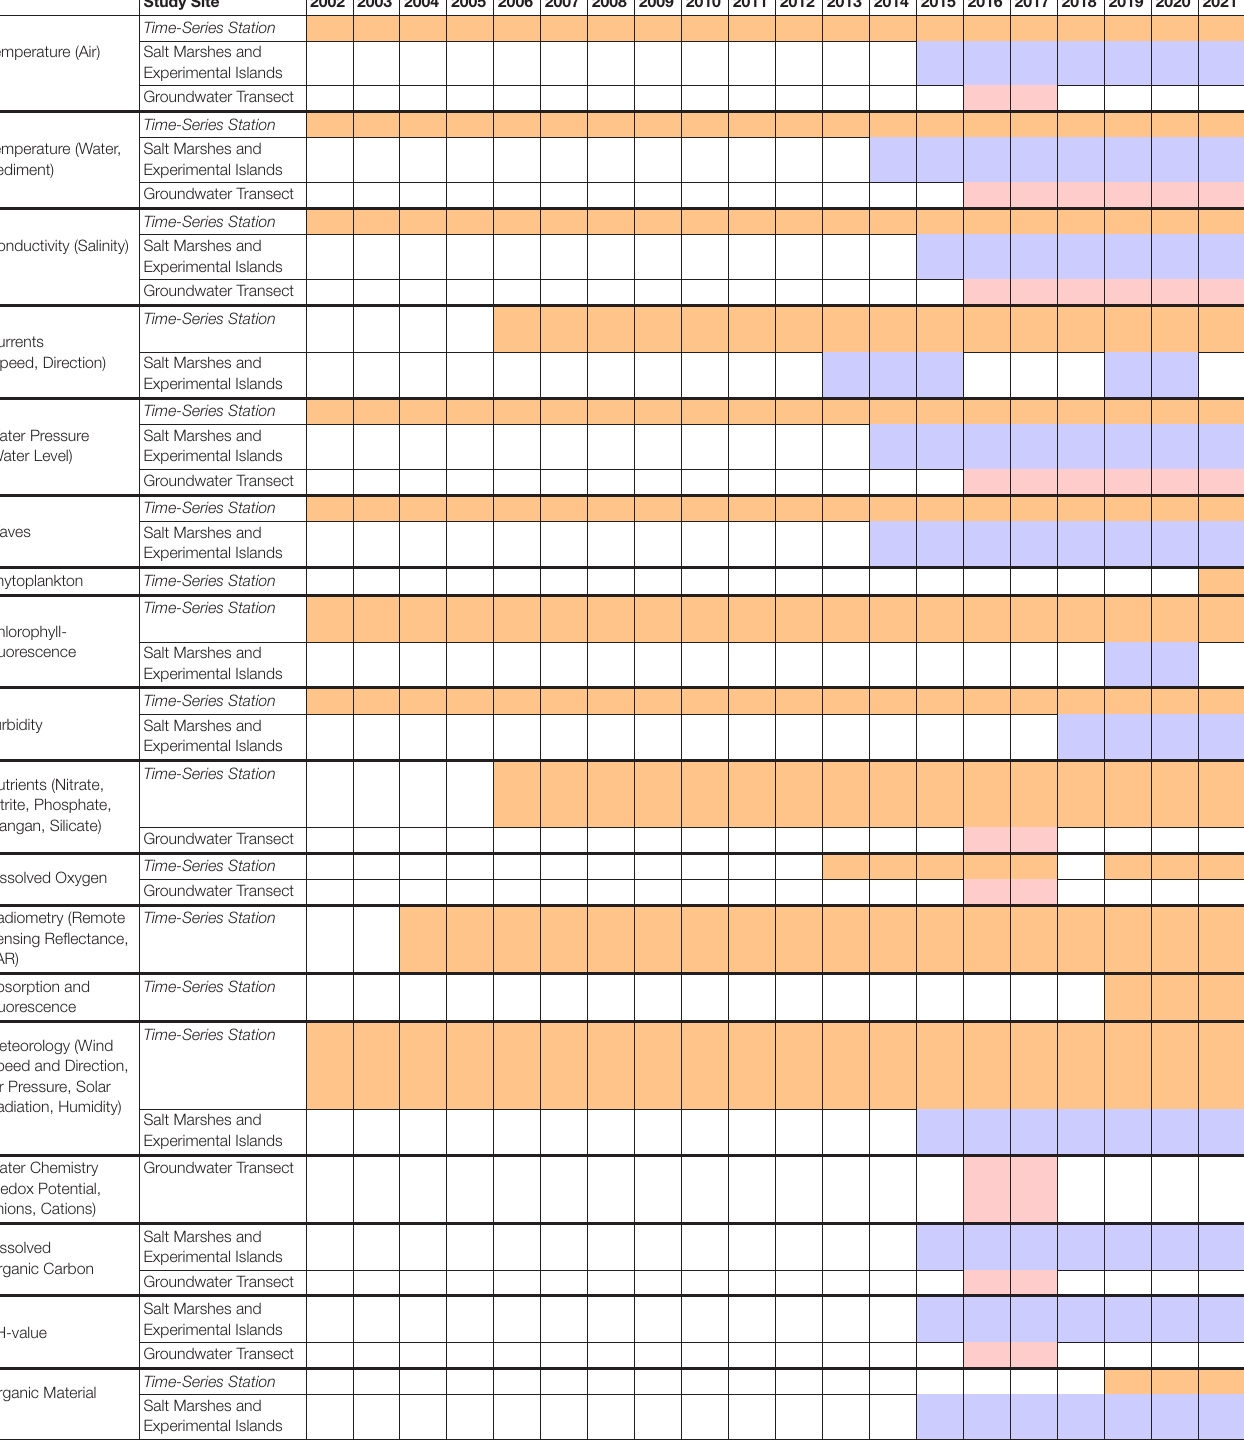
TABLE 3 | Key-parameters recorded at different study sites of the Spiekeroog Coastal Observatory . Study